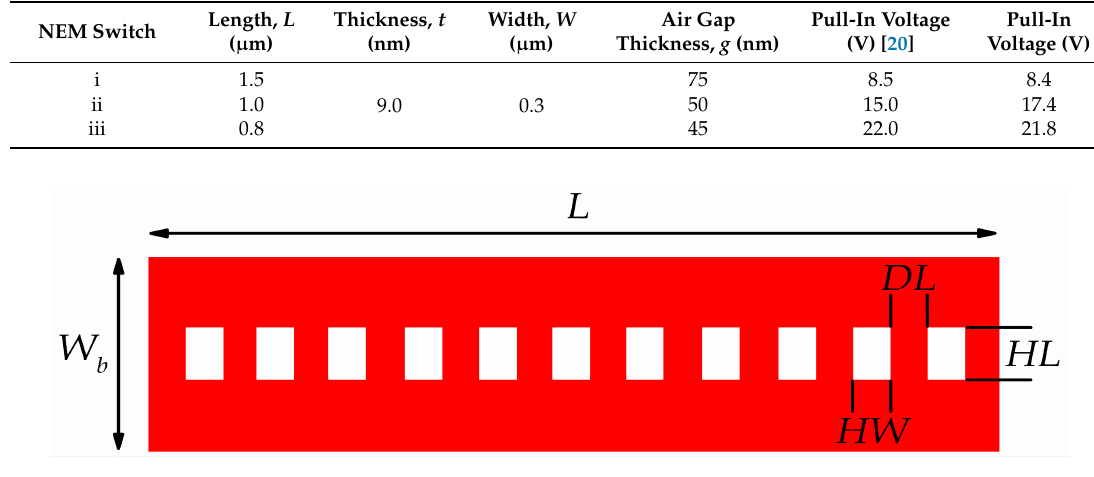
Figure 2. Top view of graphene beam structure.